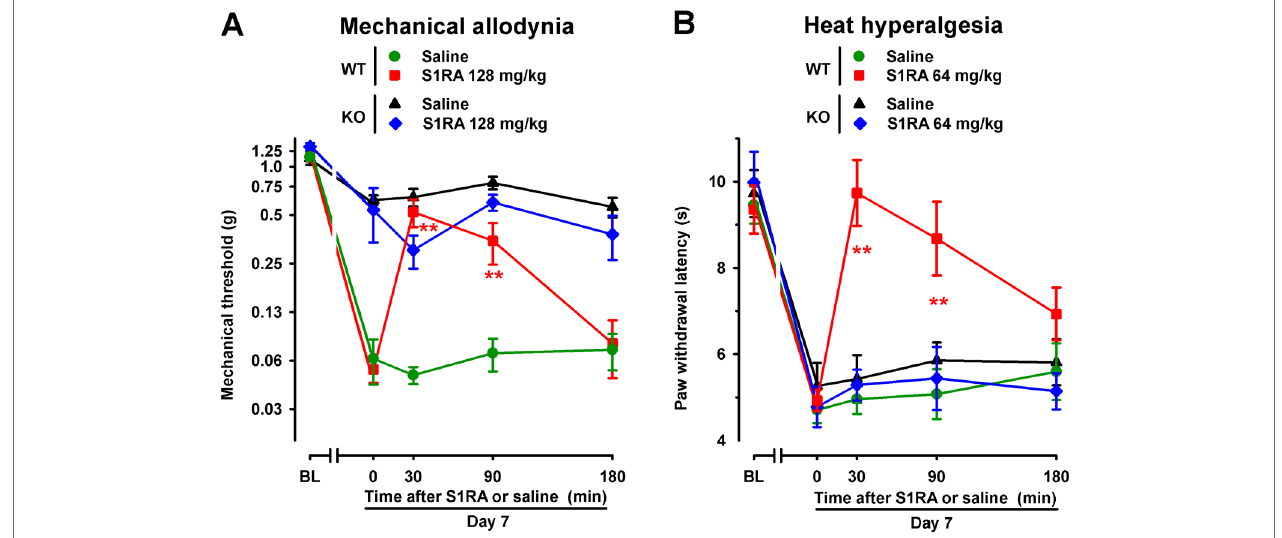
FIGURE 5 | Time course of the effects of a single s.c. injection of S1RA (64–128 mg/kg) or saline on mechanical allodynia (A) and heat hyperalgesia (B) in female WT and σ 1 -KO mice with SNI 7 days after surgery. The von Frey threshold (A) and latency to hind paw withdrawal in the Hargreaves test (B) were evaluated 1 day before (baseline, BL) and 7 days (day 7) after surgery in the paw ipsilateral to the surgery. On day 7 the responses to test stimuli were recorded immediately before (time 0) and at several times (30, 90, and 180 min) after injection of the drug or saline. Each point and vertical line represent the mean ± SEM of the values obtained in 8–14 animals. Statistically significant differences between S1RA- and saline-treated groups at the same time after treatment were found in WT mice (** P < 0.01) but not in σ 1 -KO mice (two-way repeated-measures ANOVA followed by Bonferroni